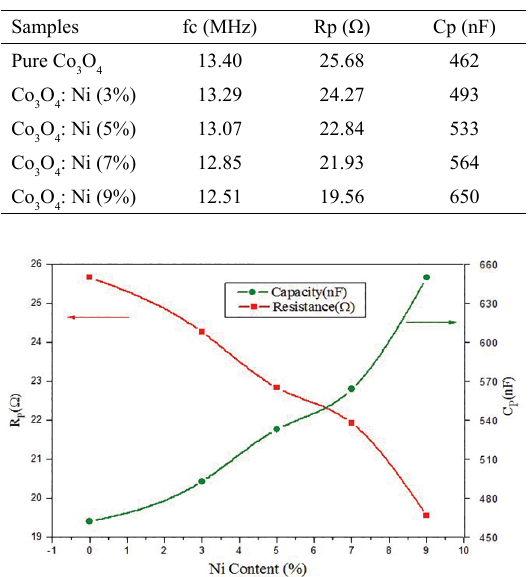
O thin films at 3 4 O films. 3 4